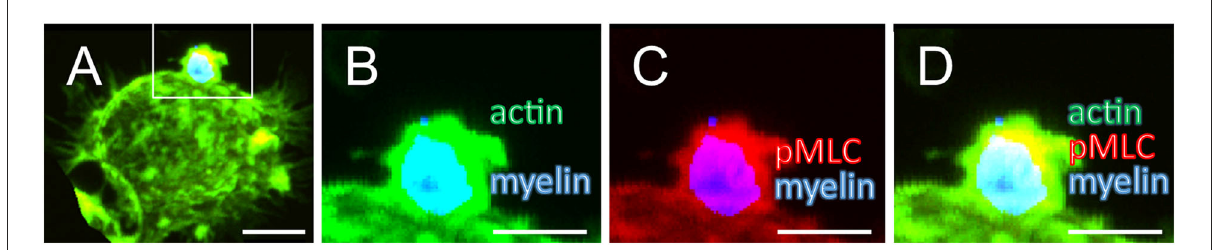
FIGURE4 Myelin debris, F-actin, and pMLC colocalize at the phagocytic cup. Myelin (blue), pMLC (red), F-actin (actin; green), and overlap of actin and pMLC (yellow). (A) A phagocytic cup on top of microglia that phagocytoses myelin debris. (B–D) Enlargement of the phagocytic cup and its immediate surroundings [the area marked in (A) ]. (B) Myelin and F-actin, (C) pMLC and myelin, (D) F-actin, pMLC and myelin. Optical slices, 1 µ m thick, were scanned sequentially, and the entire phagocyte was reconstructed. Bars: 10 µ m in (A) and 5 µ m in (B–D) . Modified after Gitik et al.